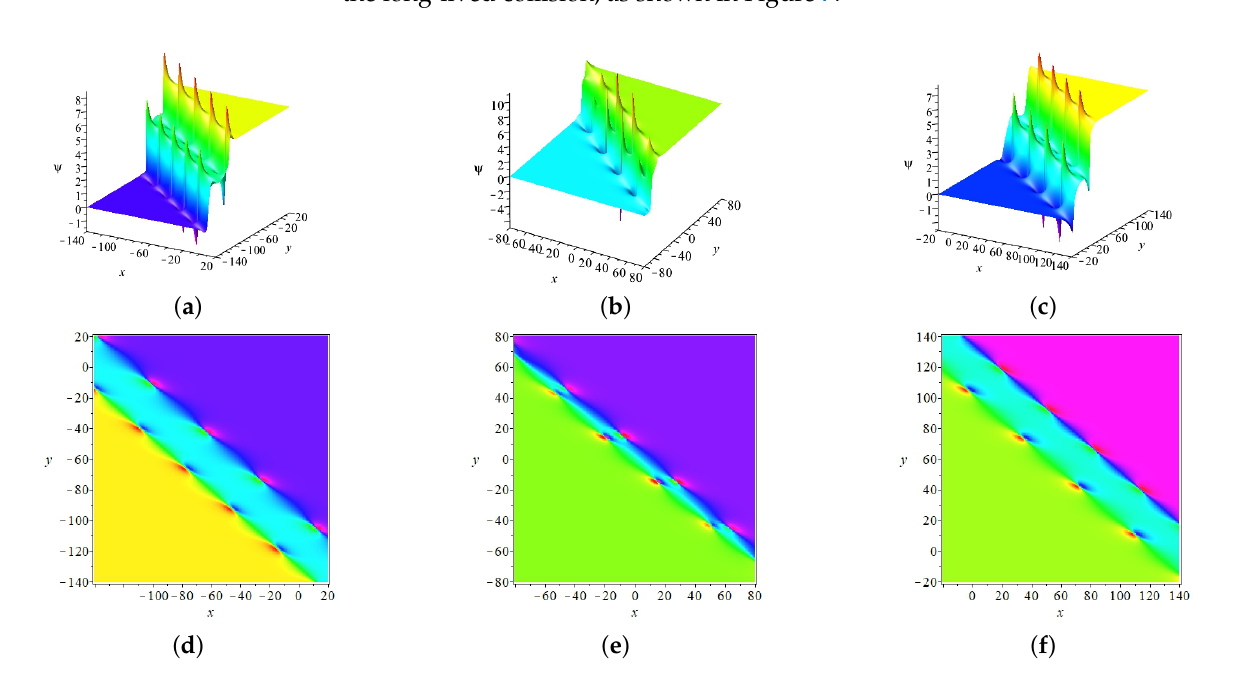
Figure 6. (Color online) The collision between parallel two-breathers with r 2 = r 3 = r 4 = r 6 = r 7 = r 8 = 1, a 1 = 0.3, b 1 = 0, c 1 = 1.2, d 1 = 0.8, e 1 = 0.75, f 1 = 0.75, β 1 = 2, γ 1 = 0, κ 1 = 0, a 2 = 0.2, b 2 = 0, c 2 = 1.2, d 2 = 1, e 2 = 2 , f 2 = 2 , β 3 = 2, γ 2 = 0, κ 2 = 0. ( a – c ) are vertical view when t = − 50, t = 0 3 3 and t = 50. ( d – f ) are contour